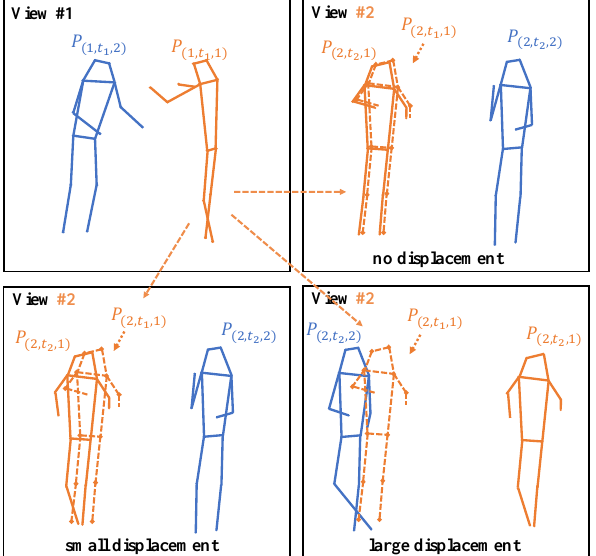
Figure 3. Illustration of multiple person association typical cases. The two frames are from two different camera views of the same or different time instant. To find the corresponding pose of the same person in the view #2 for pose P ( 1, t of view #1, we compute the distances between all poses 1 ,1 ) in view #2 and P ( 1, t . Then, the pose of least distance to P ( 1, t is selected as the correspondence. 1 ,1 ) 1 ,1 ) Note that P ( 2, t of the dashed line is a proxy for P ( 1, t , which is only for illustration. When the 1 ,1 ) 1 ,1 ) two frames are of the same time instant (upper-right), it finds the correct corresponding pose and the distance is very small. When there are small temporal displacements (lower-left), it is likely that the correct correspondence will be found, but the distance will be a little larger. When the temporal displacement is large (lower-right), the wrong correspondence could be assigned and the distance is generally much